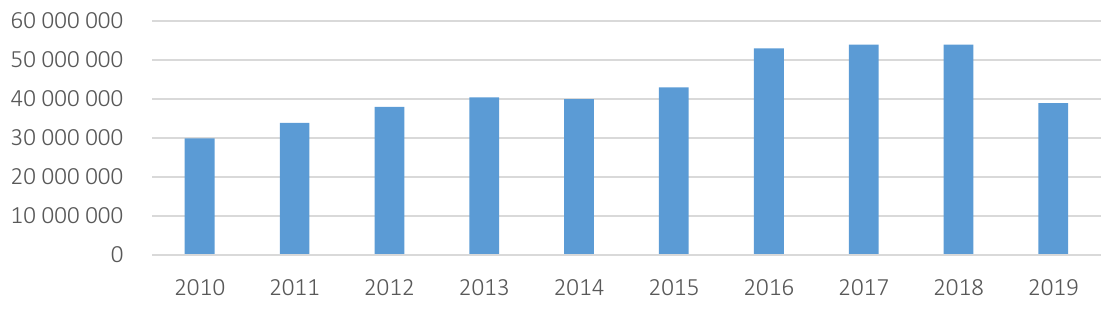
Figure 2. The bank’s net profit during the period of 2010–2019